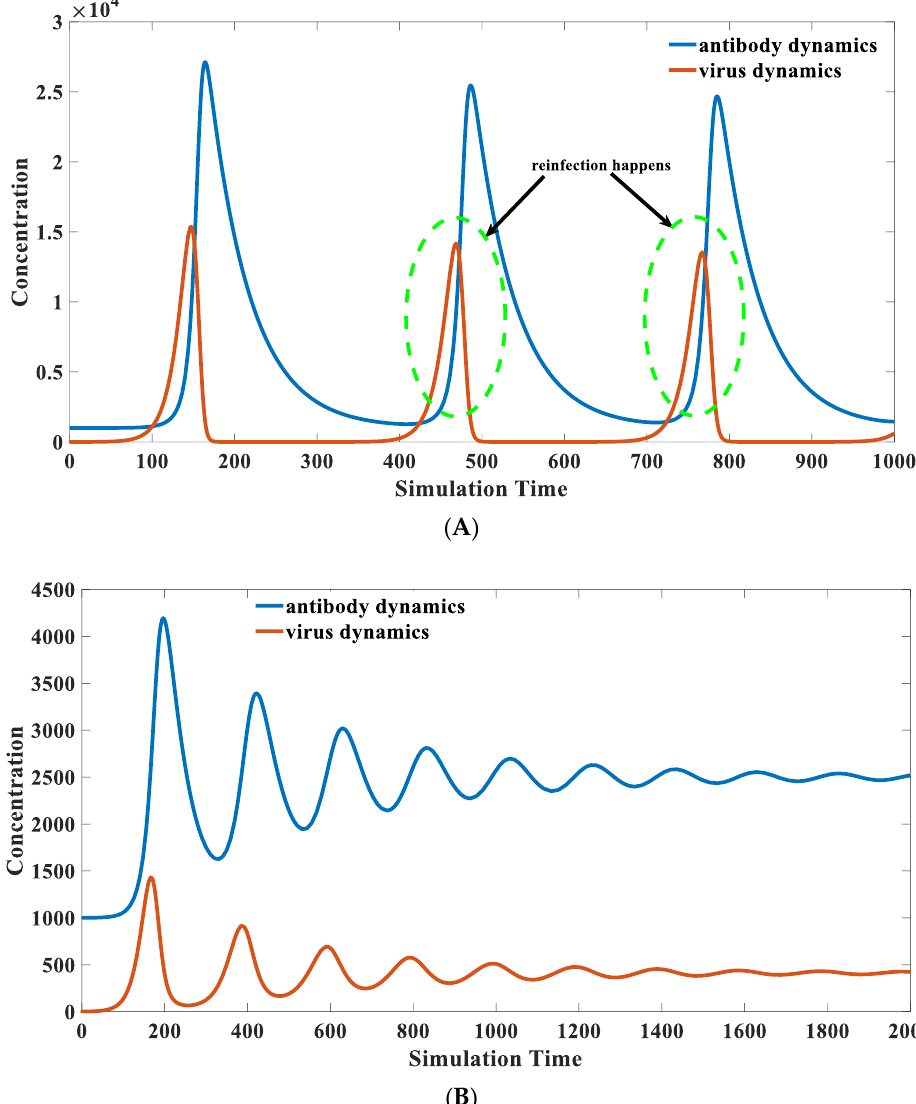
Figure 11. ( A ) Self-reinfection scenario. The parameter sets we used are: x (0) = 0, y (0) = 1000, z (0) = 1, w = 1000, k 1 = 0.1, k 2 = 1 × 10 − 5 , k − 2 = 1 × 10 − 14 , k 3 = 1, k 4 = 2, k 5 = 0.02, k 6 = 0.02. Reinfections are represented as repeated waves in this figure. It indicates that the viruses could re-proliferate when the antibodies cannot completely eliminate them. The viruses start to proliferate when the antibodies drop to a certain level, leading to self-reinfection in this case. ( B ) Scenario of chronic infection. The parameter sets we used are: x (0) = 0, y (0) = 1000, z (0) = 1, w = 1000, k 1 = 0.1, k 2 = 3 × 10 − 5 , k − 2 = 1 × 10 − 5 , k 3 = 1, k 4 = 2, k 5 = 0.02, k 6 = 0.02. In this case, pathogens would not be eliminated but maintained at a relatively stable level, forming a chronic infection. The low concentration of pathogenic antigens only provides a limited driving force for promoting antibody